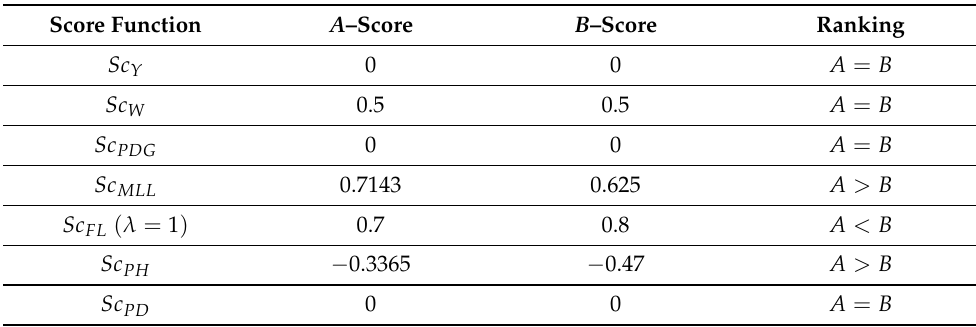
Table 1. The ranking of p − ROFS A = ( 0.3,0.3 ) and B = ( 0.2,0.2 ) with existing score functions with p = 1.